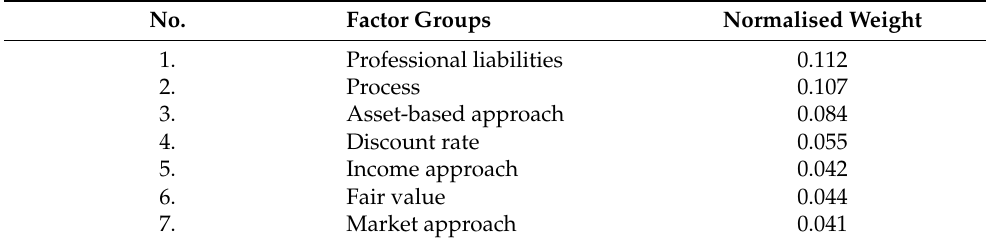
Table 3. Normalized Weight of Risk Groups.